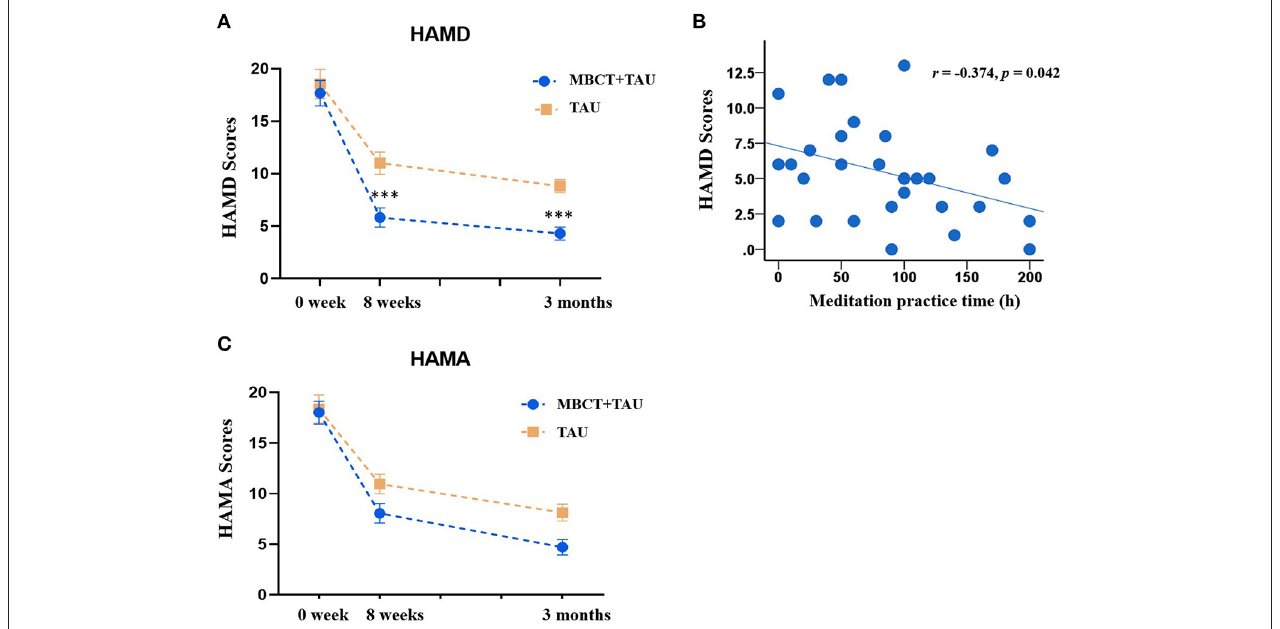
FIGURE 2 | Clinical measures from baseline to endpoints in the two groups. (A) Changes in HAMD scores in the MBCT + TAU group and TAU group. (B) Correlation between meditation practice time and HAMD scores. (C) Changes in HAMD scores in the MBCT + TAU group and TAU group. *** p < 0.001.